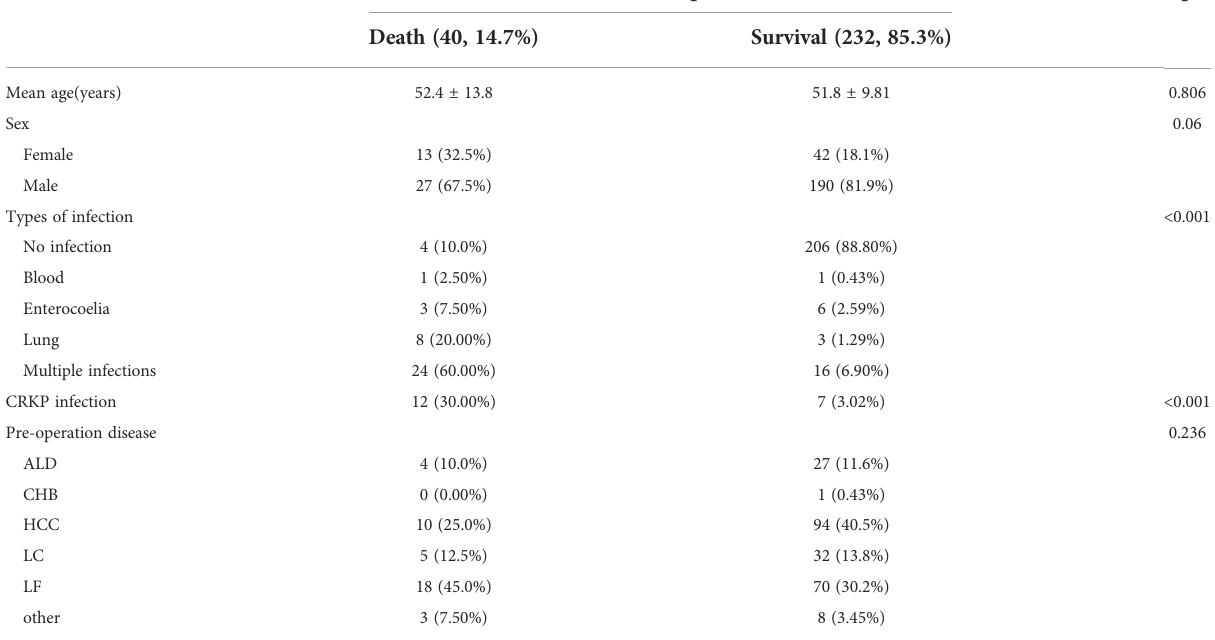
TABLE 1 Clinical information of liver transplant